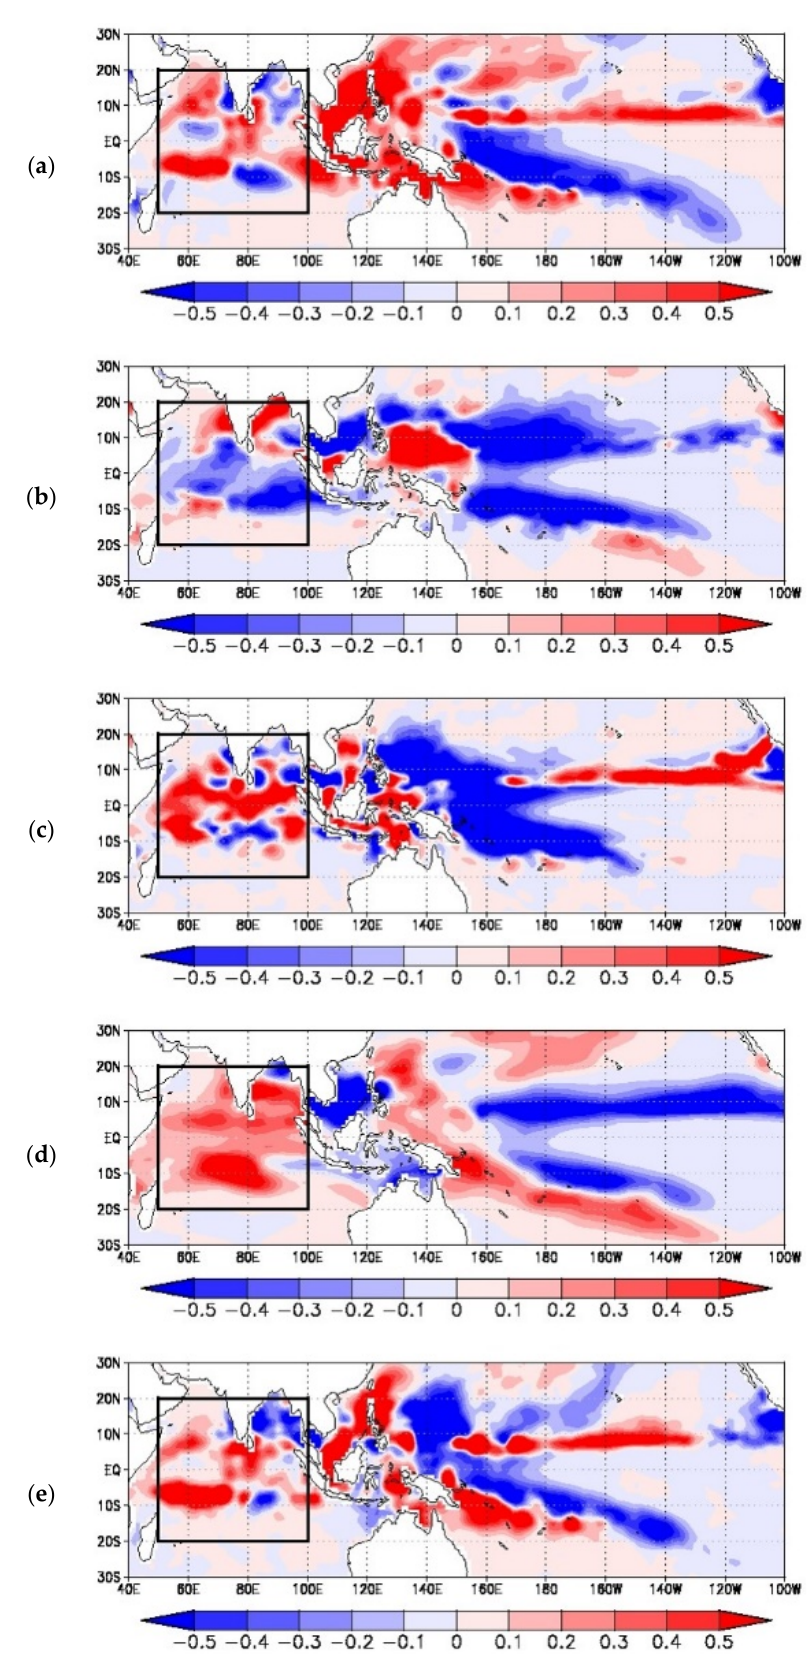
Figure 3. The degrees of the contributions to GPI anomalies in the 2011 case from ( a ) relative humidity; ( b ) vertical shear; ( c ) vorticity; ( d ) MPI; and ( e ) vertical velocity.